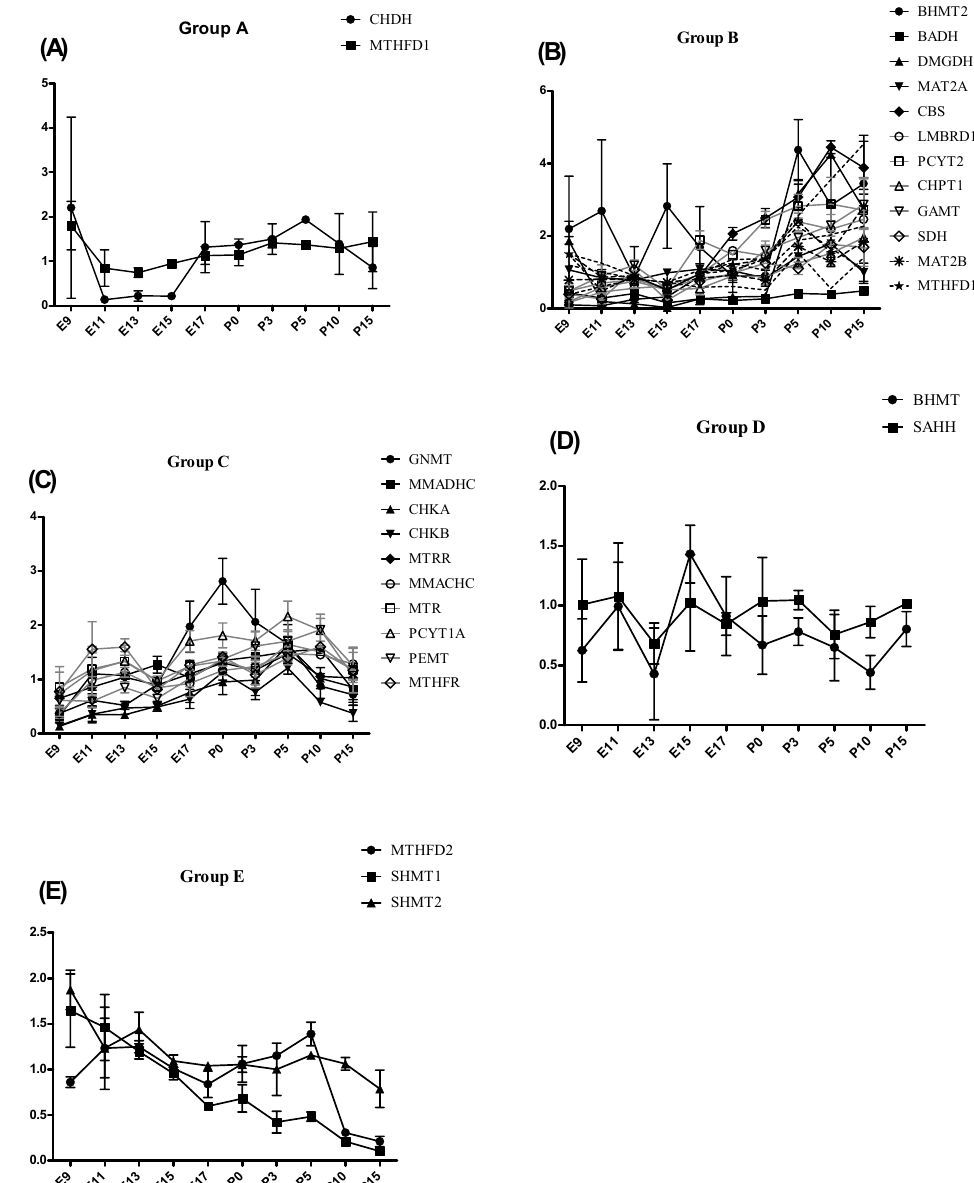
Figure 6. Variation of the expression of 1C metabolism genes in mouse brain ontogenesis. ( A ) Group A genes. ( B ) Group B genes. ( C ) Group C genes. ( D ) Group D genes. ( E ) Group E